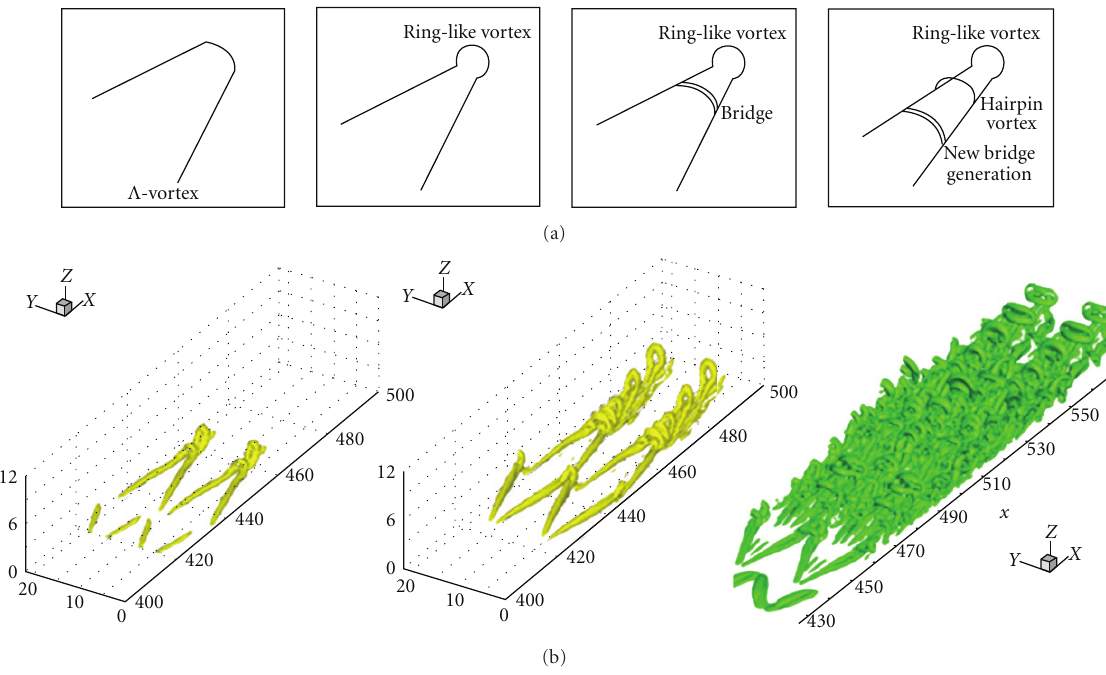
Figure 17: (a) Sketch for mechanism of multiring generation, (b) multiple ring